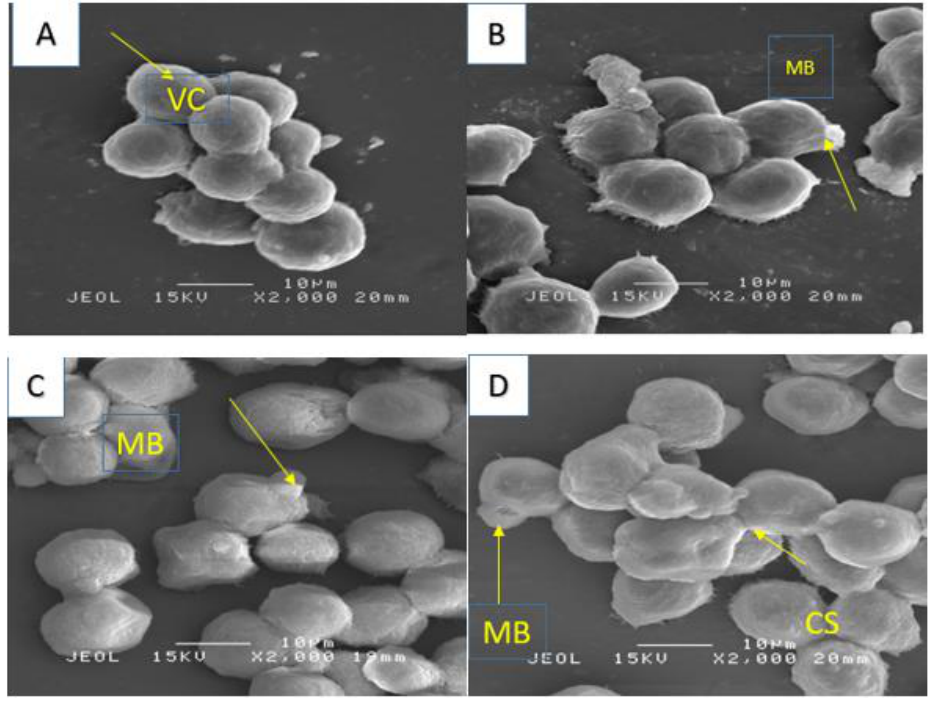
Figure 15. SEM micrograph for MDA-MB-231 cell line. Untreated cells ( A ), treated cells 24 h ( B ), 48 h ( C ) and 72 h, respectively ( D ). (VC) viable cells; MB, membrane blebbing; CS, cytosolic shredding.